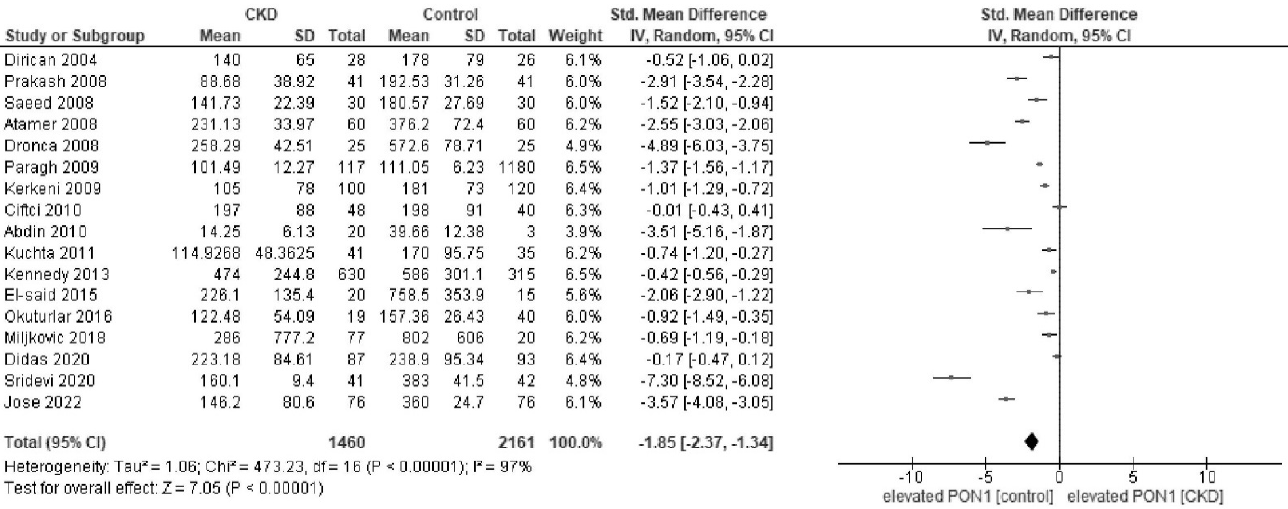
Figure A5. Forest plot of arylesterase activity stratified by regions [28,30,32,34,39,41–43,45–47].